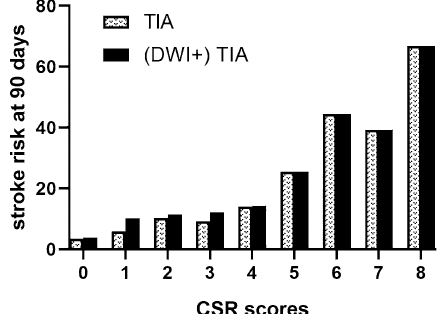
Figure 1. Stroke risk at 90 days according to CSR score.